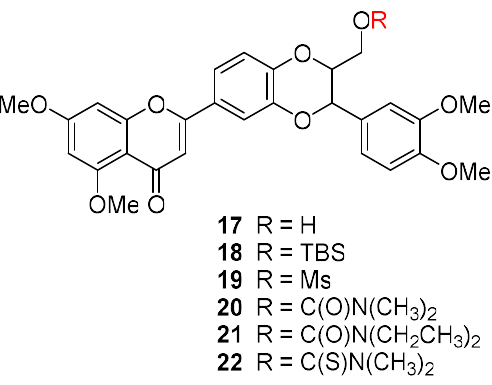
Figure 3. Chemical structures of 5,7,20- O -trimethylhydnocarpins.